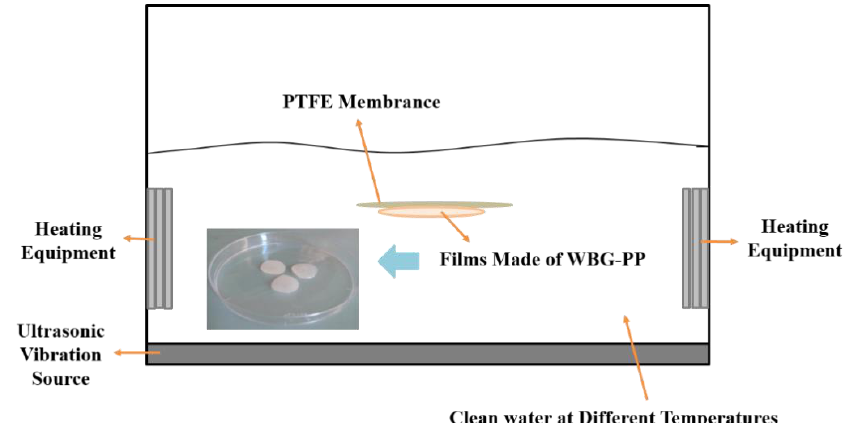
Figure 2. Device diagram of β -nucleating agent polypropylene (WBG-PP) thin film prepared by ultrasound.